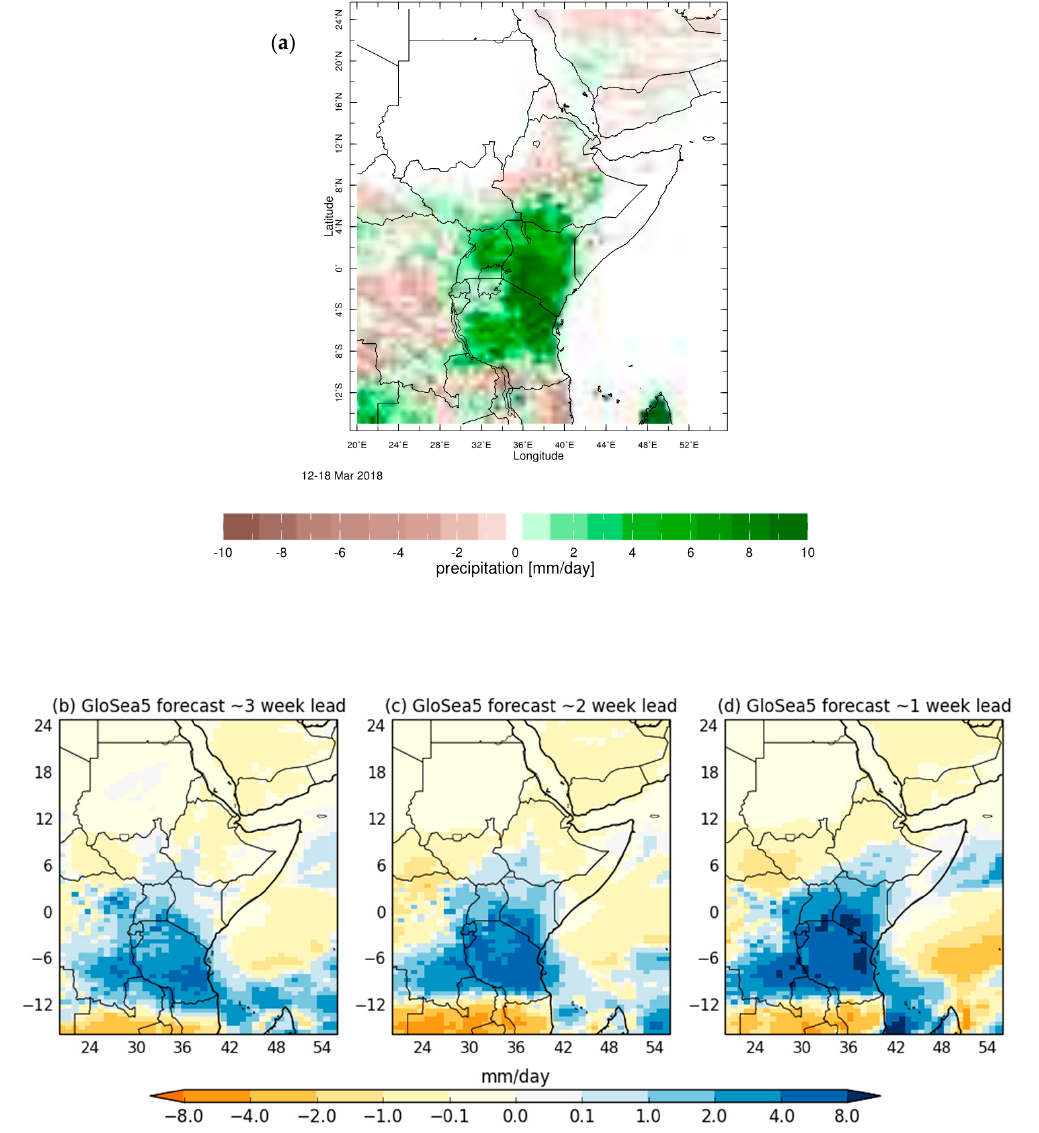
Figure 14. ( a ) Rainfall anomaly 12–18 March 2018 (CHIRPS: data and image courtesy the International Research Institute (IRI) Data Library); ( b – d ) corresponding GloSea5 ensemble mean predicted rainfall anomalies and nominal initialization of: ( b ) 19 February (three-week lead); ( c ) 26 February (two-week lead); and ( d ) 5 March (one-week lead).